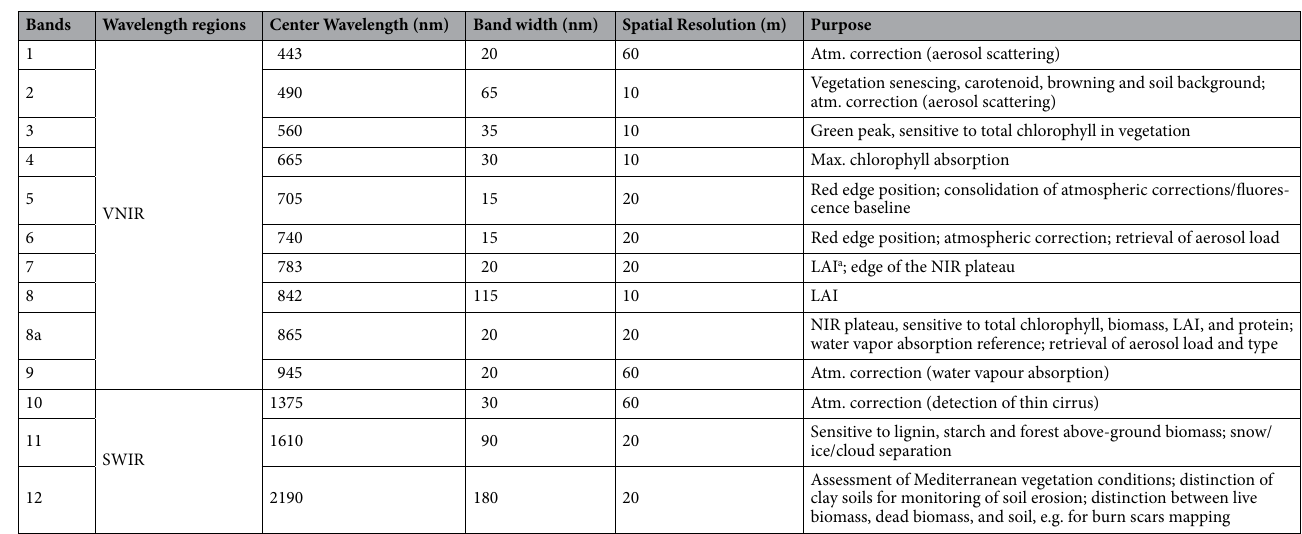
Table 2. Sensor characters of Sentinel-2 bands according to the Copernicus derived user requirements 71 . a LAI = Leaf Area